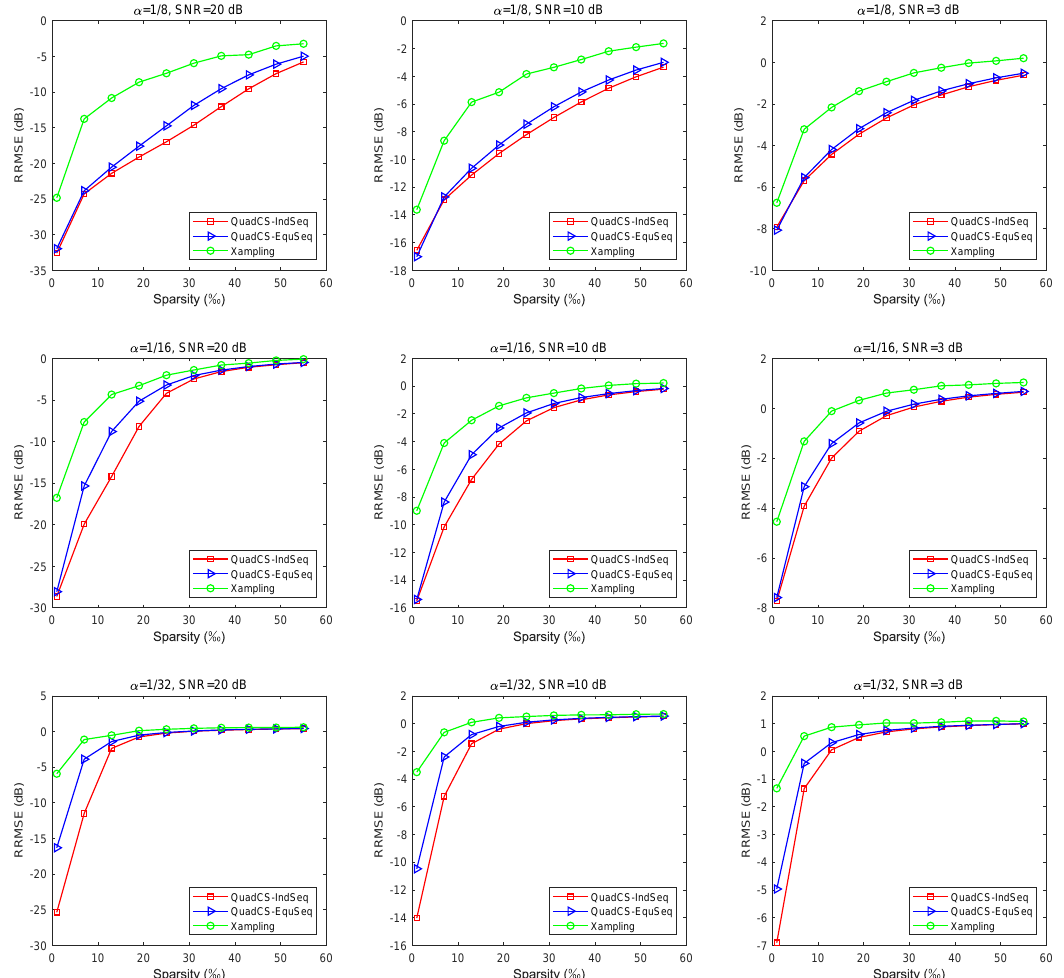
Figure 6. RRMSE vs. sparsity (averaged by 100 times). From top to bottom: compression ratios, denoted by α , are 1/8, 1/16, and 1/32, respectively. From left to right: SNR = 20 dB, SNR = 10 dB and SNR = 3 dB, respectively. We can see that QuadCS-IndSeq has the smallest RRMSE in all